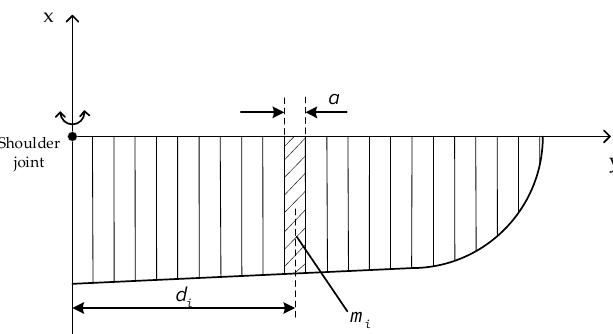
Figure 5. Wing strip for calculating inertia of a flapping wing.